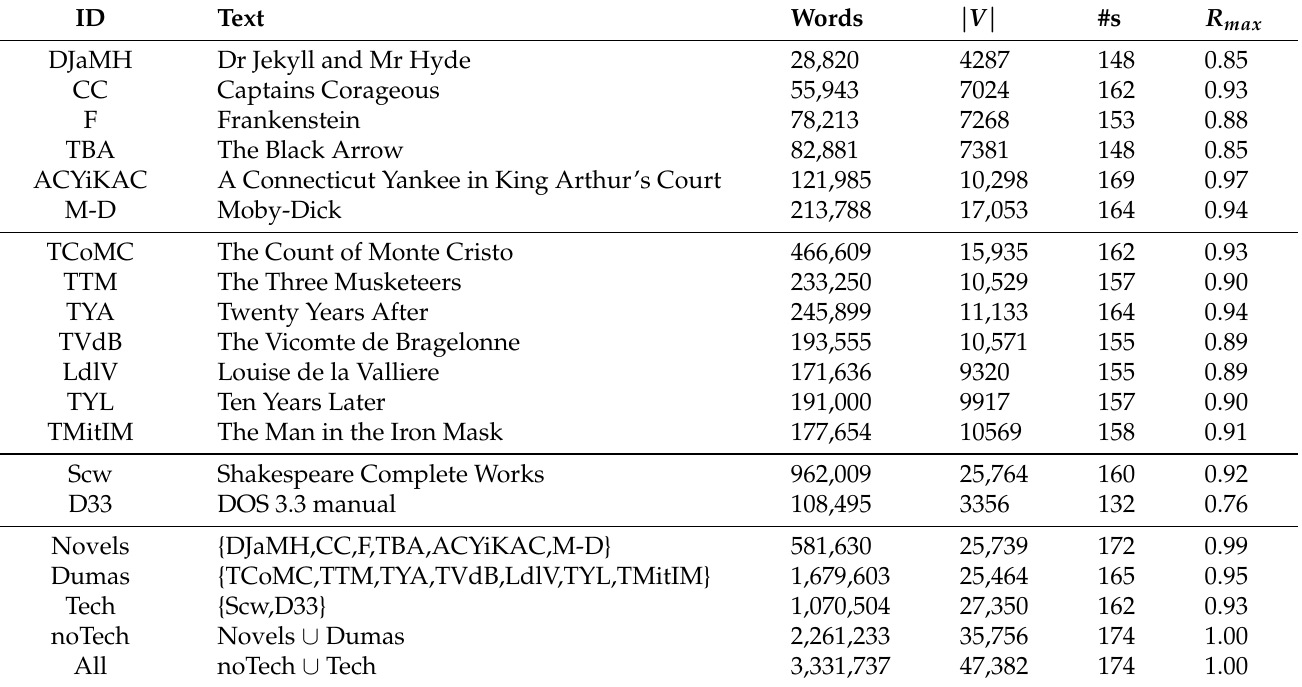
Table 1. English